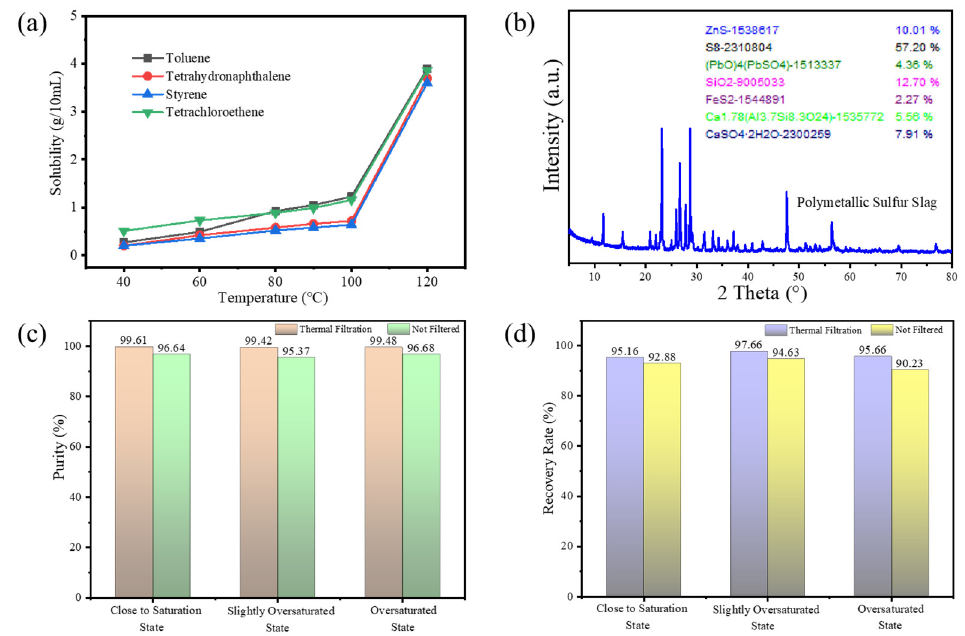
Figure 1. Solubility curves of sulfur in different organic solvents ( a ); XRD analysis of PSS ( b ); comparison of purity ( c ) and recovery rate ( d ) of sulfur recovered by thermal filtration and non-filtration from PSS.